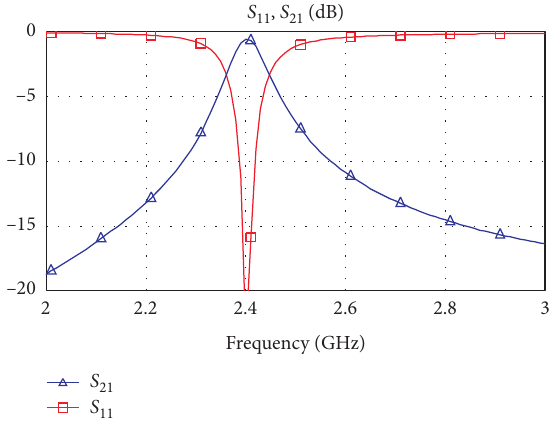
Figure 7: Magnitudes of elements of the patch antenna scattering matrix.